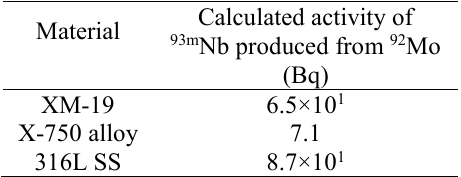
Table 5. Calculated activity of 93m Nb produced from 92 Mo.